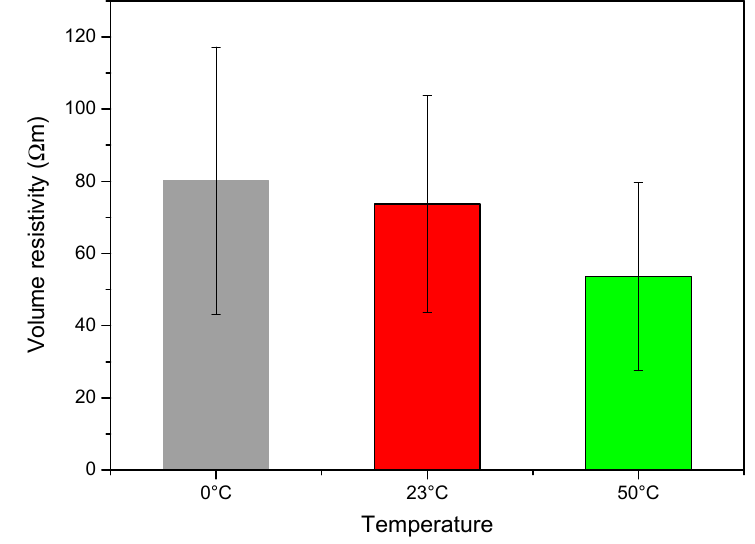
Figure 6. Electrical volume resistivity of EP-rGO-GF composite at different temperatures.